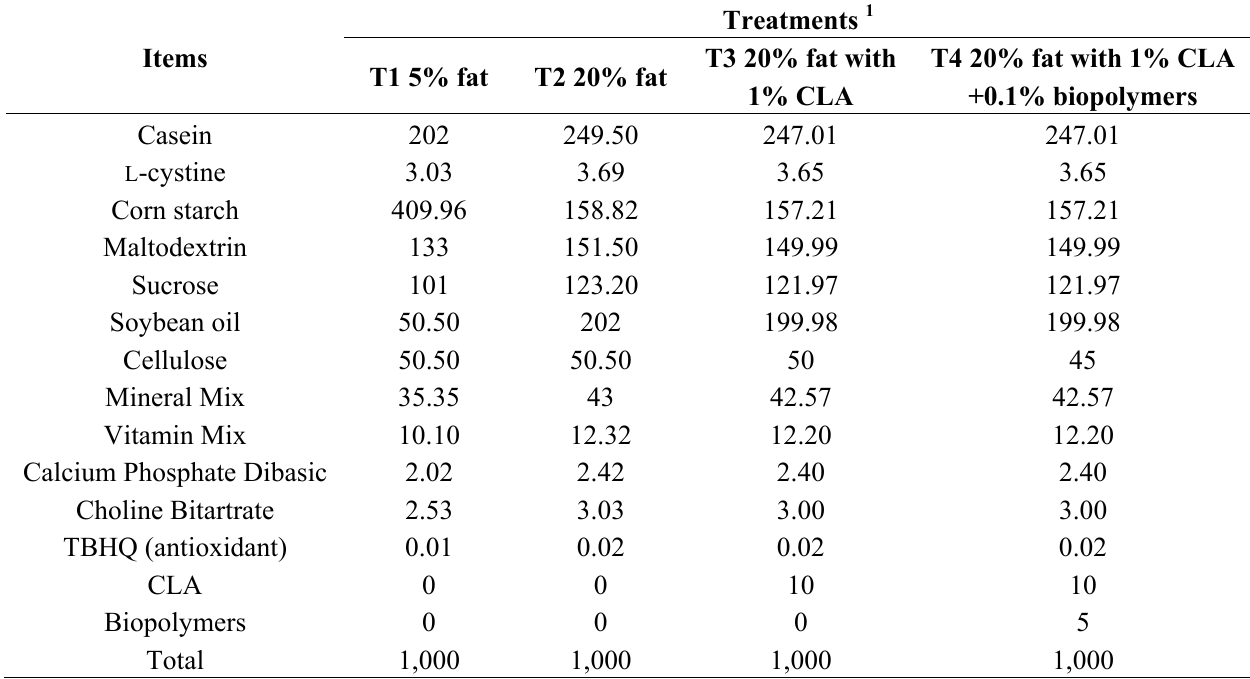
Table 2. Experimental diets and treatment